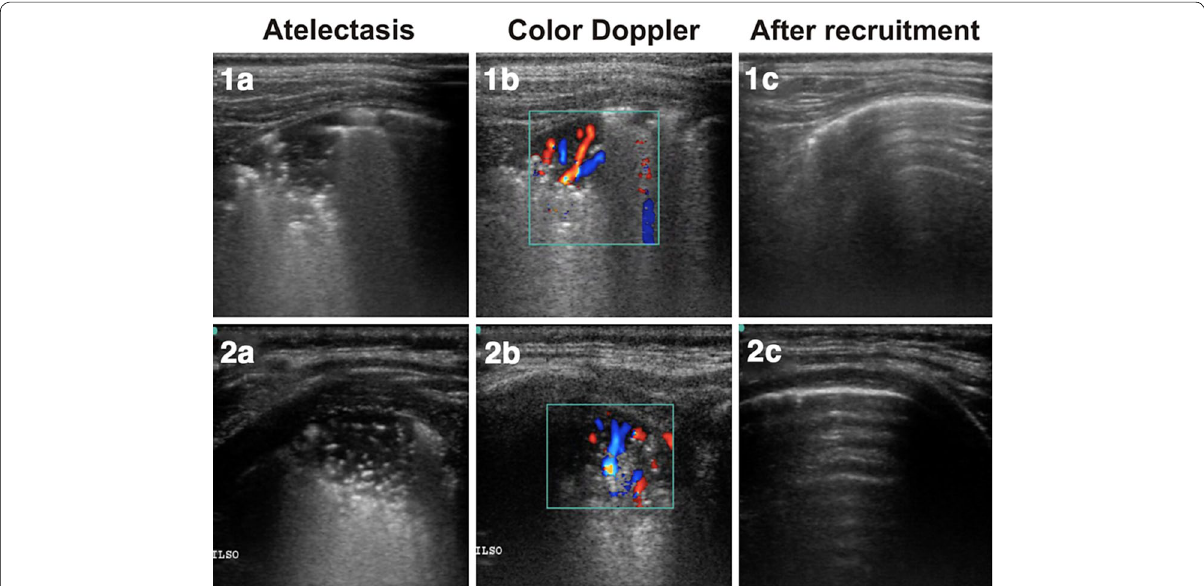
Fig. 2 Color Doppler images of intra‑pulmonary shunt. The images belong to two mechanically ventilated anesthetized children: (1) 1 year old and (2) 2 months old. a Atelectasis is observed as subpleural consolidations with air bronchograms and coalescent B‑lines. b Color Doppler revealed lung vessels within the atelectasis showing a radial distribution to the lung periphery. c Normal lung tissue after successful treatment of the atelectasis by a recruitment maneuver, the normal aeration prevents the pulmonary vessels from being seen by lung sonography. These images correspond to the Additional file 1: Video